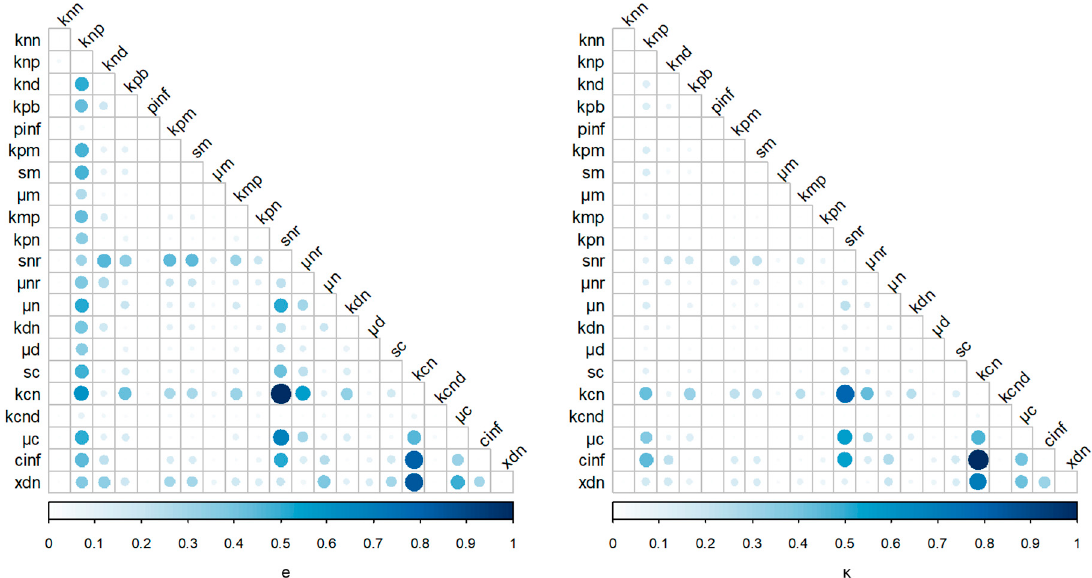
Figure 5. Control efficiency ( e ) and strength ( κ ) values for the different parameters of the four-variable model. Circle size and color indicate the value of e and κ . Normalized units of efficiency and strength are shown for presentation purposes.